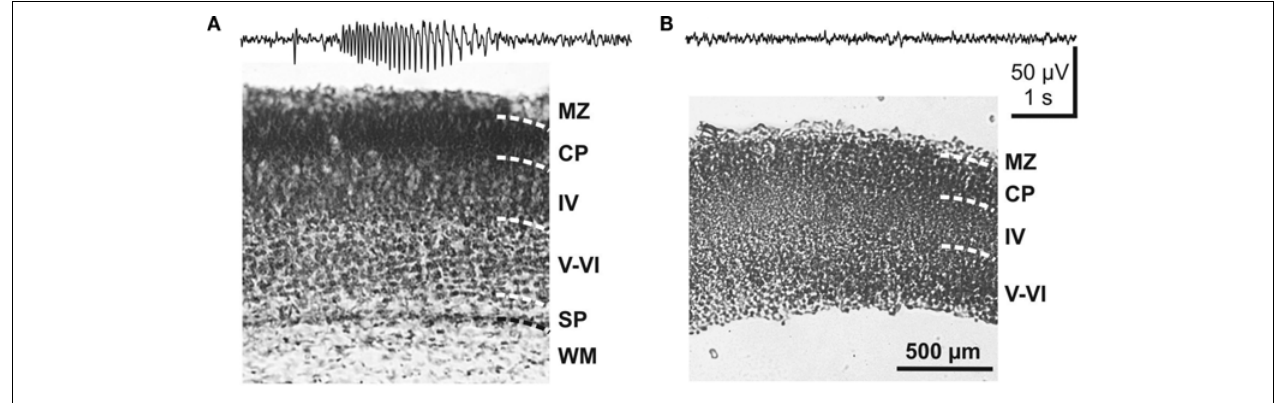
FIGURE 6 | Role of the subplate in triggering carbachol-induced network oscillations in the neonatal mouse cerebral cortex. (A) Field potential response to carbachol application in a coronal 800-µm thick cortical slab preparation with an intact subplate as shown in Nissl stained